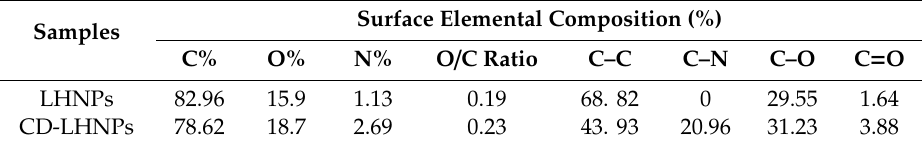
Table 1. Elemental distribution of LHNPs and CD-LHNPs, and their outer surfaces.